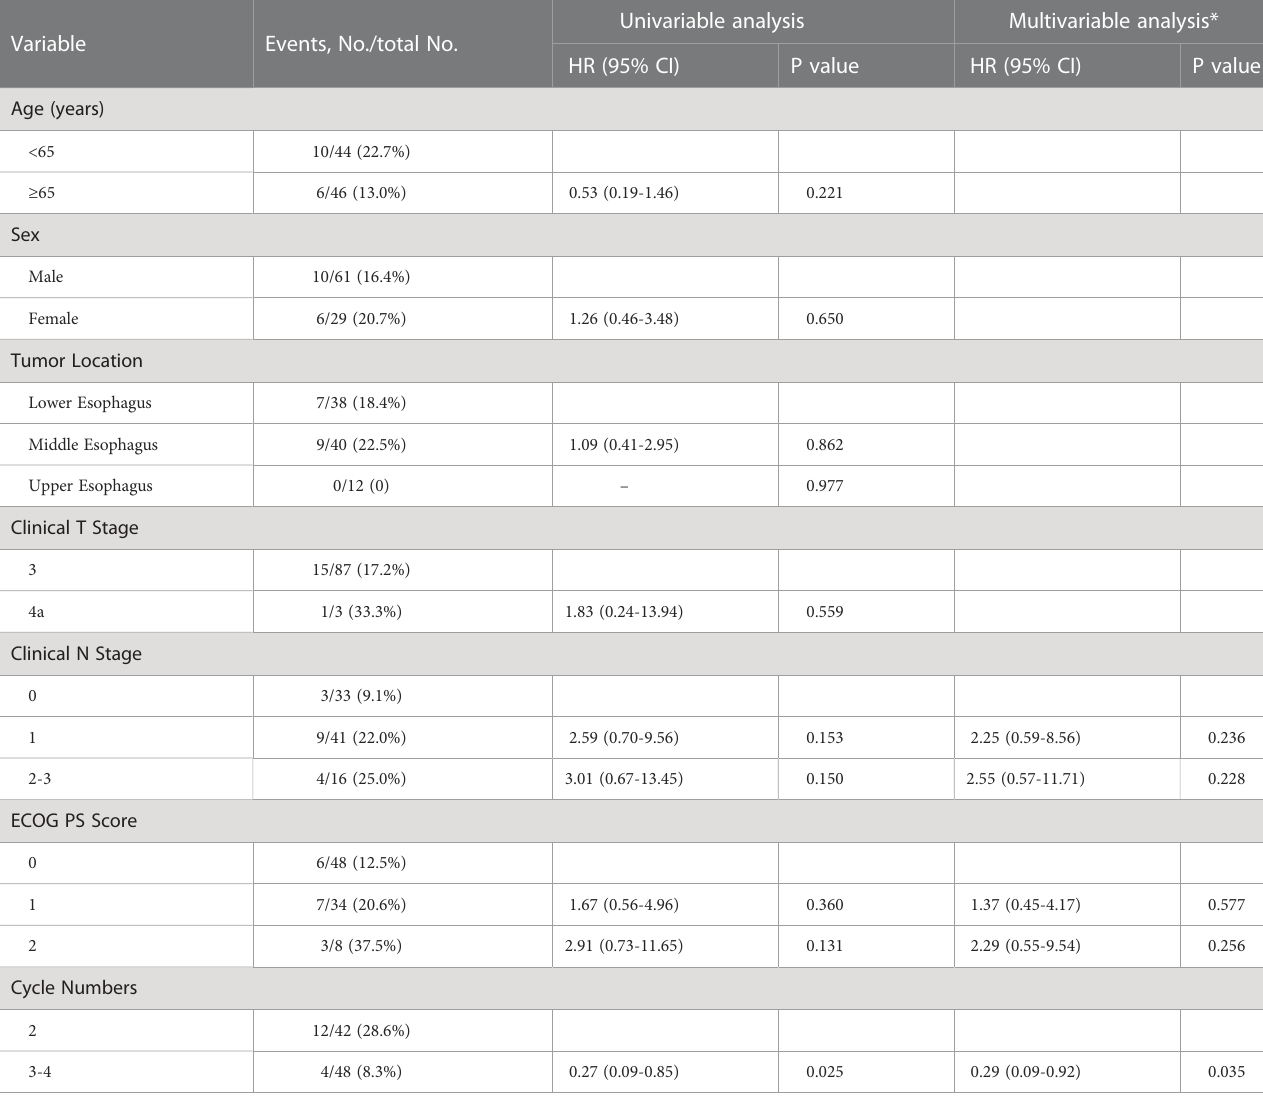
TABLE 5 Univariable and multivariable Cox regression analysis according to baseline characteristics.